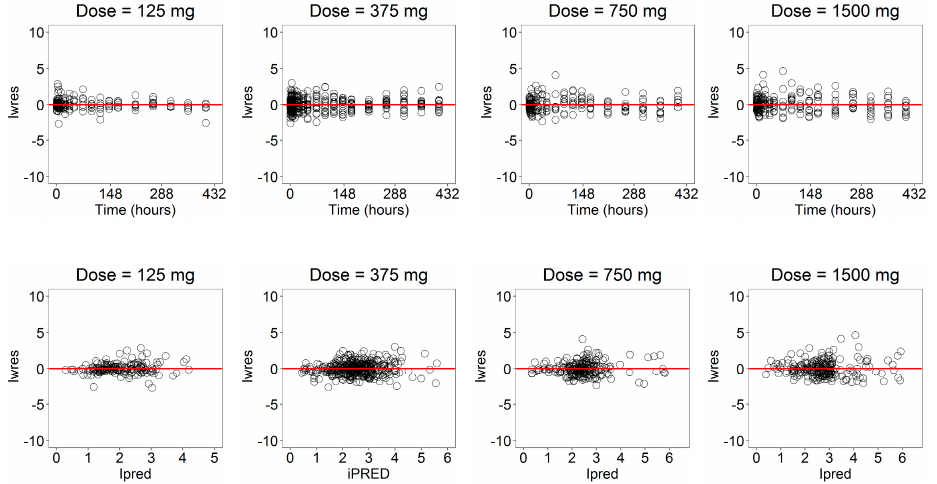
Figure 9. Weighted residuals for the serum concentration of progesterone are plotted against time ( upper panels) and individual prediction ( lower panels) stratified on the dose levels.